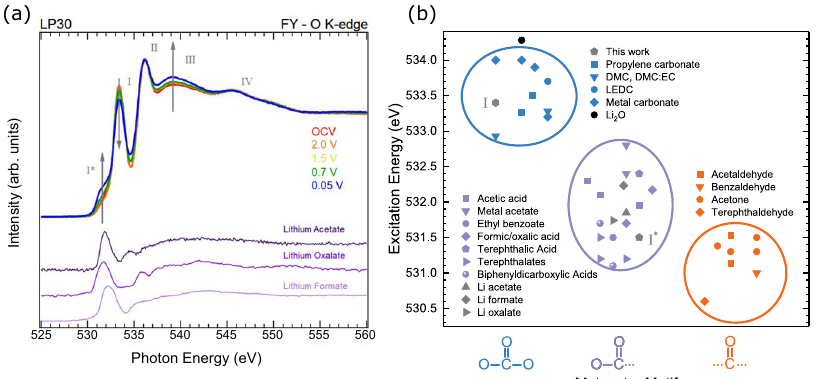
Fig. 5 | Comparison of Operando O K-edge XAS with various C=O containing reference compounds.a FY-XASofthe O K-edge taken during cycling atdifferent potentials ranging from OCV down to 0.05V. Reference spectra of materials sharing the -C(=O)O- structural motif are also shown for comparison. b Excitation energies of the O 1 s → π * transition for a number of molecules possessing an C=O